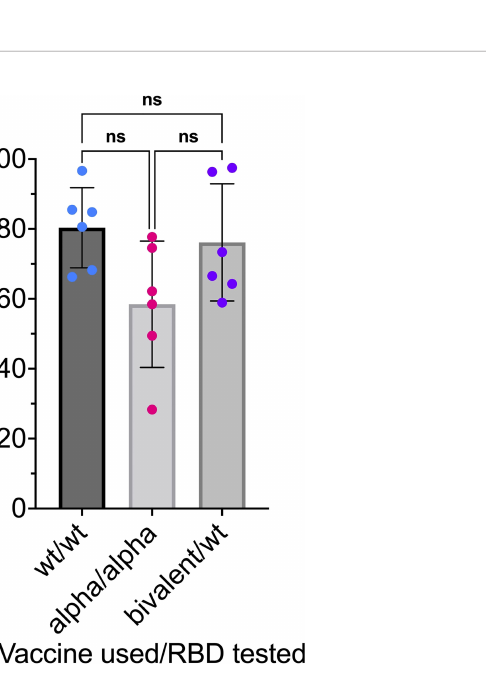
FIGURE 13 | Anti-RBD neutralizing antibodies compared in sera induced by monovalent and bivalent mRNA RBD-NP vaccines: CB6F1/J female mice 8 weeks old were primed at week 0 and boosted at week 3 by needle-free i.m. injection at the caudal thigh with the modi fi ed Tropis ® injector and the same dose (42µg/50µl) of three different mRNA RBD-NP vaccines. Group 1 (n= 6) received the monovalent mRNA RBD wt -NP vaccine with wild type RBD (RBD wt ). Group 2 (n= 6) received the monovalent mRNA RBD Alpha -NP vaccine with Alpha variant RBD (RBD Alpha ). Group 3 (n= 6) received the bivalent mRNA vaccine with equal dose of mRNA RBD wt - NP and mRNA RBD Alpha -NP. Serum samples collected in week 6 were analyzed with the SARS-CoV-2 neutralization antibody assay with different HRP conjugated RBDs. G1 was tested for RBD wt -ACE2 interaction, G2 was tested for RBD Alpha -ACE2 interaction and G3 was tested for RBD wt -ACE2 interaction. p values in one- way ANOVA multiple comparison: wt/wt vs. bivalent/wt = 0.89; wt/wt vs. Alpha/Alpha = 0.07; Alpha/Alpha vs. bivalent/wt = 0.16. No signi fi cant difference among the means of monovalent and bivalent vaccines for inhibition of RBD-ACE2 interaction by anti-RBD neutralizing antibodies. ns, not signi fi